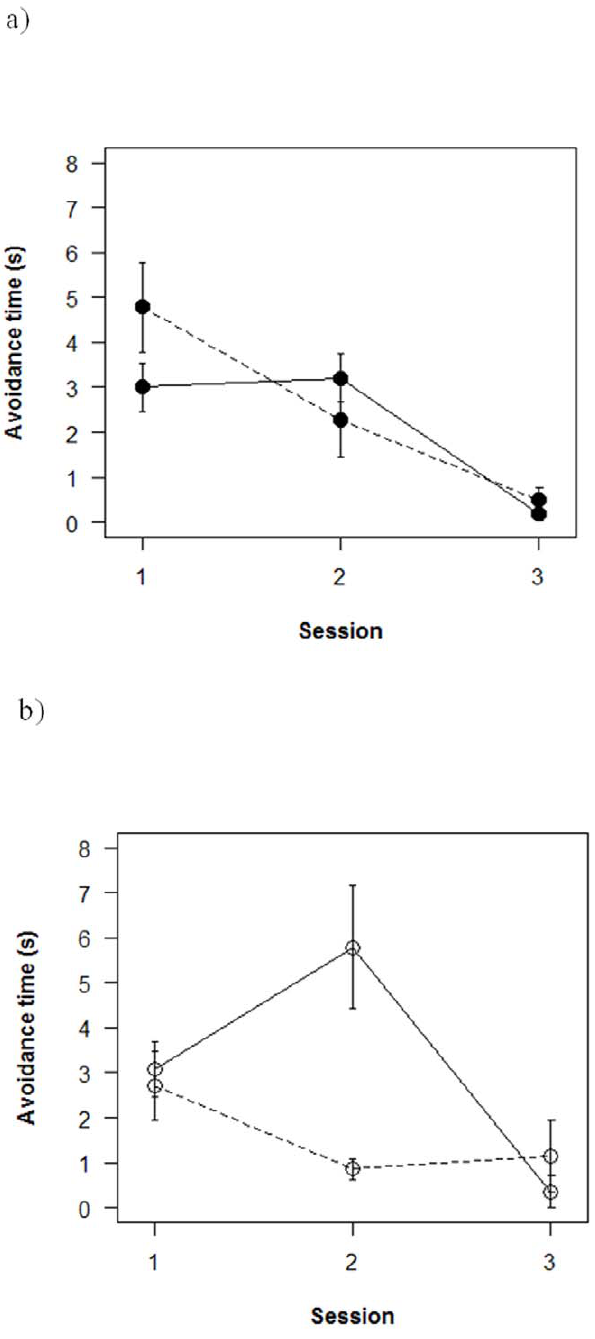
Figure 2. Individual zebrafish decreased escape time from an aversive stimulus across three sessions. 2a) Female SH zebrafish (dashed lines) decreased escape time by the second session, whereas female PN zebrafish (solid lines) generally took until the third session to evade effectively. 2b) Male zebrafish showed a steady improvement in response time regardless of strain, leading to a sex 6 strain interaction effect during the second training session. Error bars are one standard